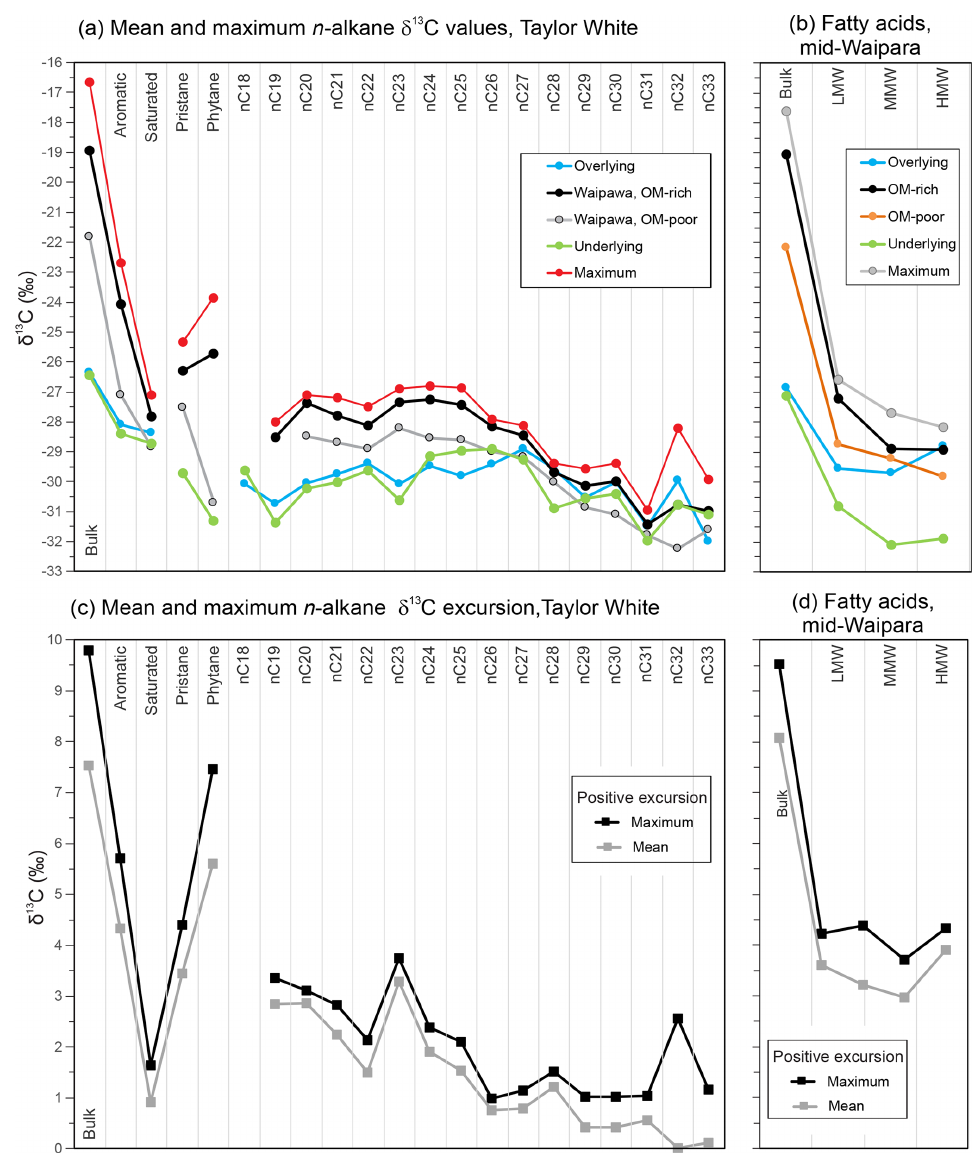
Figure 11. Mean compound group and compound-specific δ 13 C values for the four facies (underlying, overlying, OM-rich and OM-poor Waipawa) and maximum values for Waipawa organofacies in the (a) Taylor White and (b) mid-Waipara sections and mean and maximum positive δ 13 C excursion values for the (c) Taylor White and (d) mid-Waipara sections. The excursion values were derived by subtracting OM-rich Waipawa mean and maximum values from mean values for the underlying